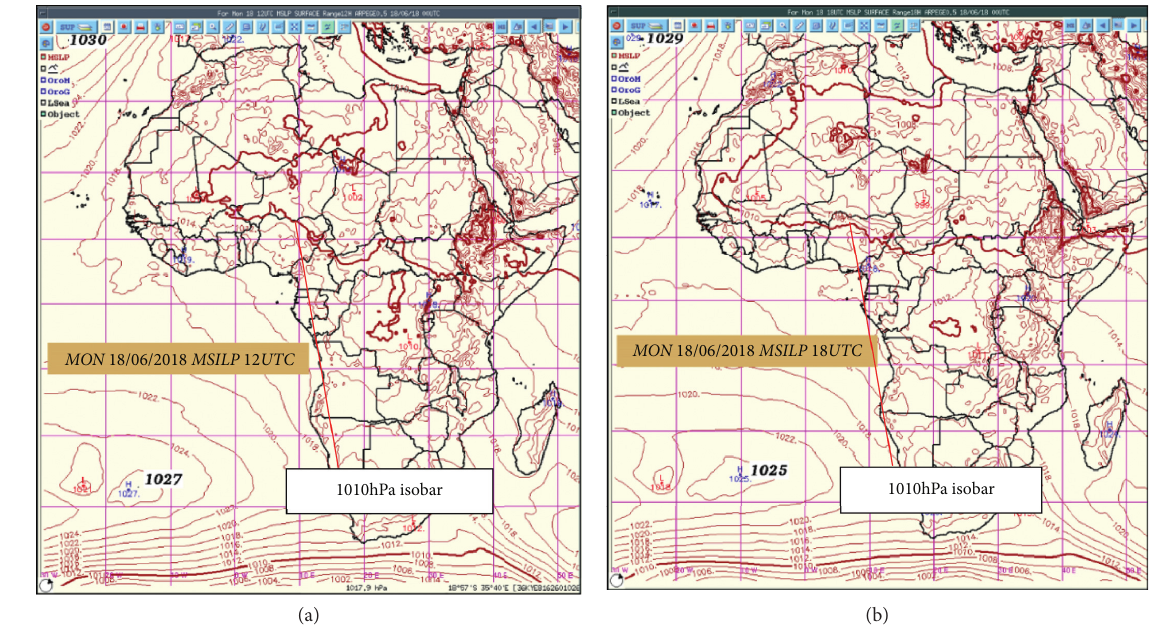
Figure 10: Meteo France Arpege 0.5 MSLP charts. (a) 12 UTC and (b) 18 UTC for case A. Table 1: The 68% and 95% of the area of normal distribution for cases A and B from annual daily maximum rainfall (mm), respectively. 68% area of normal distribution 95% area of normal distribution Event μ – ε μ +